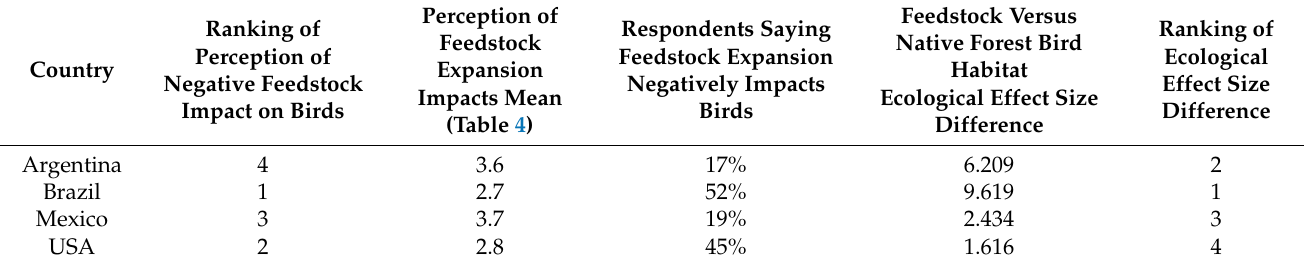
Table 5. Combined and ranked percentage survey respondents saying bioenergy expansion would negatively impact birds and ecological data effect size for bioenergy feedstock versus native forest bird habitat. Bold numbers indicate a match between the public perception of feedstock impacts and the actual ecological